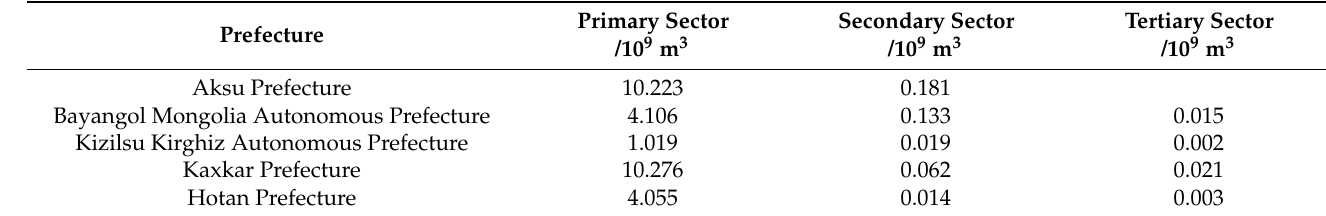
Table 2. Water consumption in various regions of the Tarim River